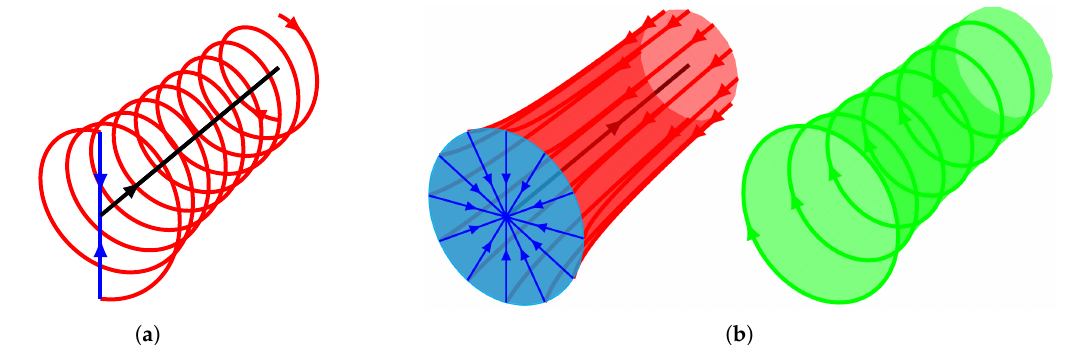
Figure 1. ( a ) Joukowsky vortex model: blade vortices (blue), root vortex (black), helicoidal wake vortices (red). ( b ) Actuator disk model: disk sheet vortex (blue), root vortex (black), wake sheet with meridional vorticity (red), wake sheet with tangential vorticity